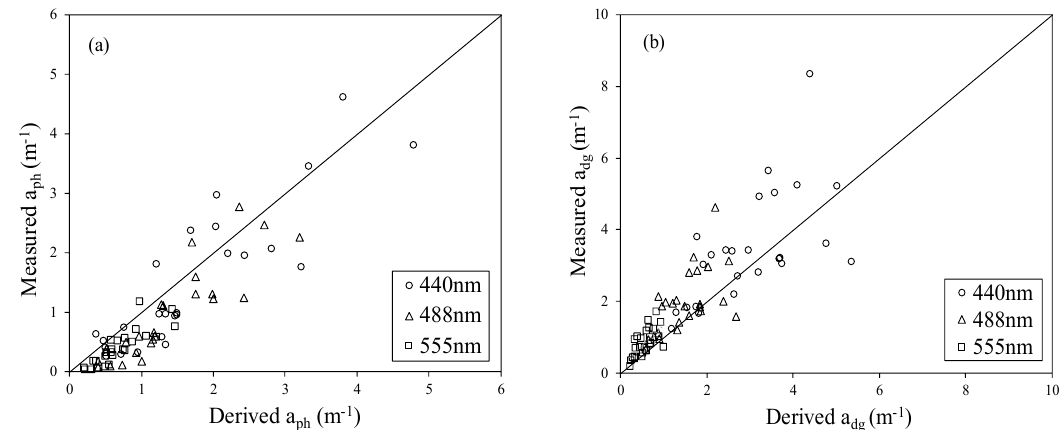
Figure 11. Comparison of derived ( a ) a ph ( λ ) and ( b ) a dg ( λ ) versus measured values at 440, 488, and 555 nm.